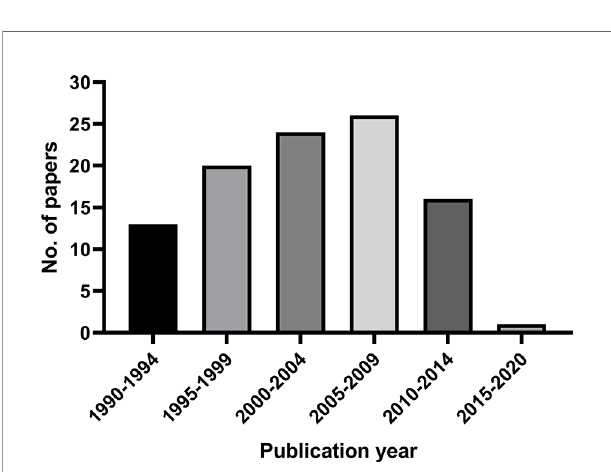
FIGURE 1 | The publication time distribution of the 100 most cited papers in radiotherapy or concurrent chemoradiotherapy for cervical cancer between 1990 and